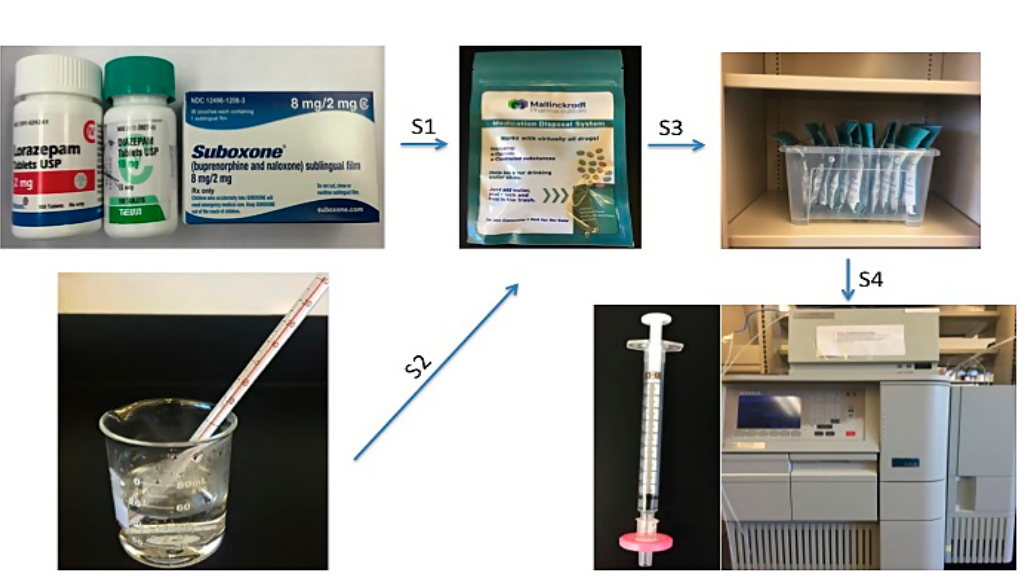
Figure 1. Schematic representation of deactivation study of psychoactive medications. S1: Medications were added to the deactivation pouches; S2: 50 mL warm tap water was added to each pouch; S3: Pouches were stored upright and undisturbed at room temperature; S4: Samples were collected at different time points and analyzed by HPLC.